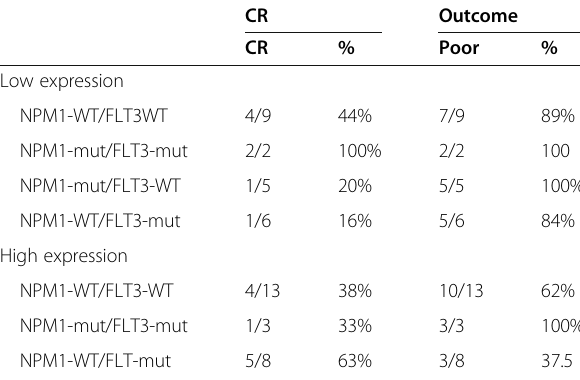
Table 4 Combined effect of HOTAIR and mutation analysis